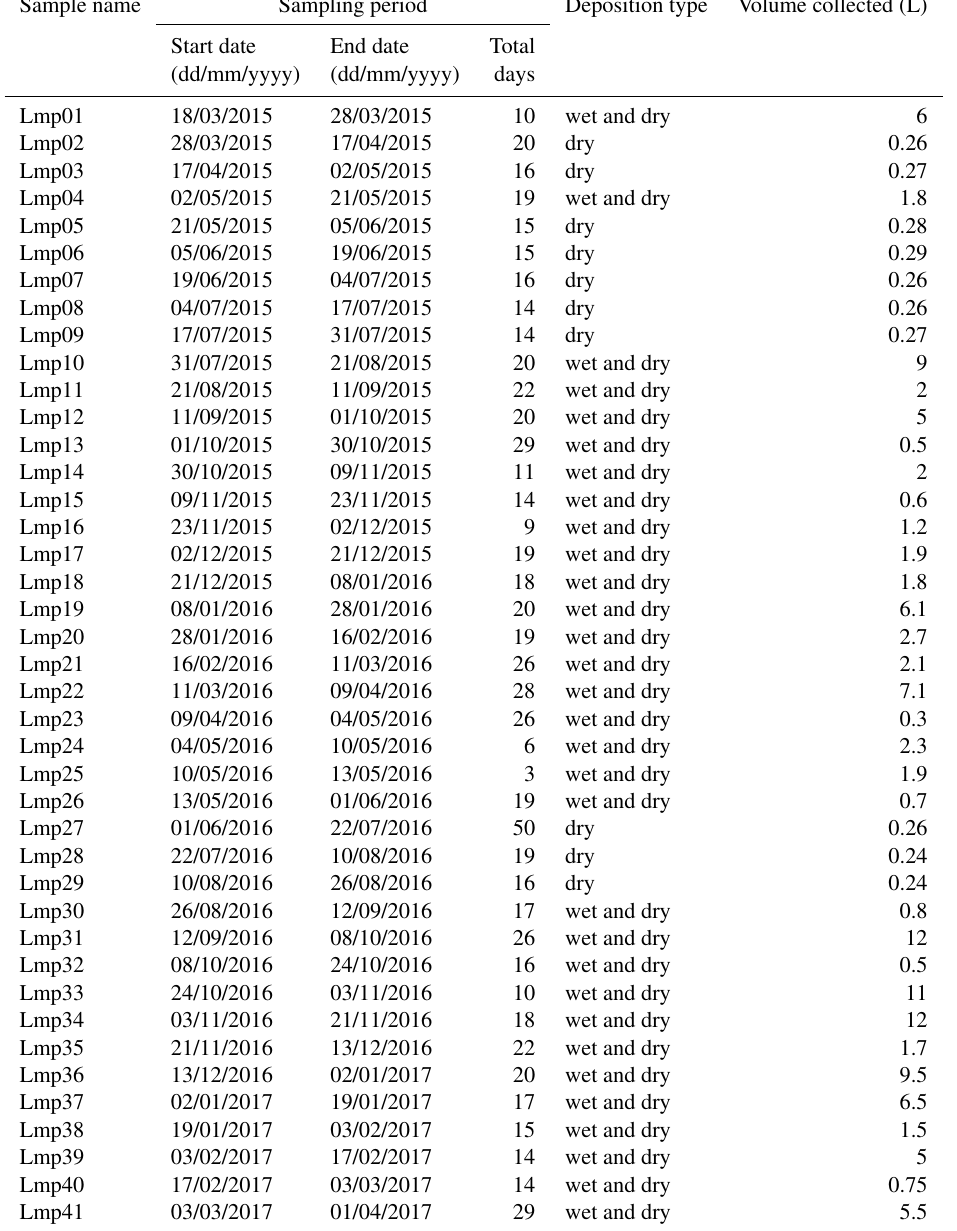
Table 1. Sampling period, type of deposition, and volume for the 41 samples collected on the island of